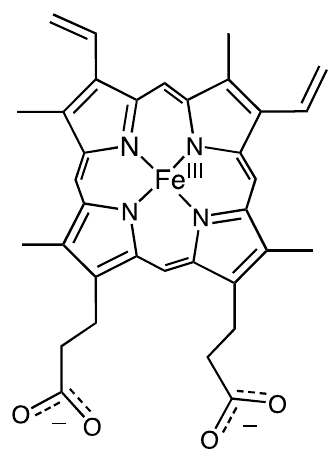
Figure 1. Structure of iron(III) protoporphyrin IX (heme b ). Cofactor found in the described heme proteins.